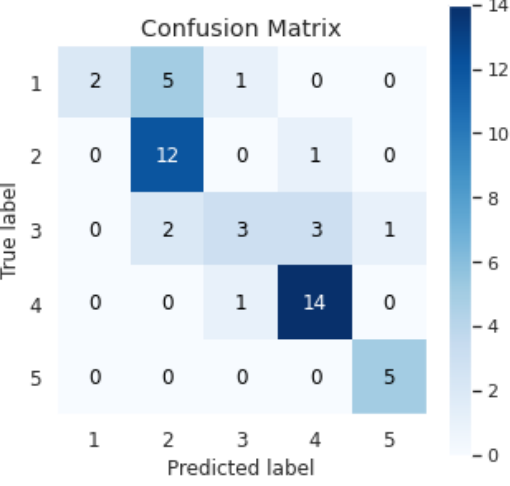
Figure 7. Confusion matrix of 50 movie reviews for sentiment